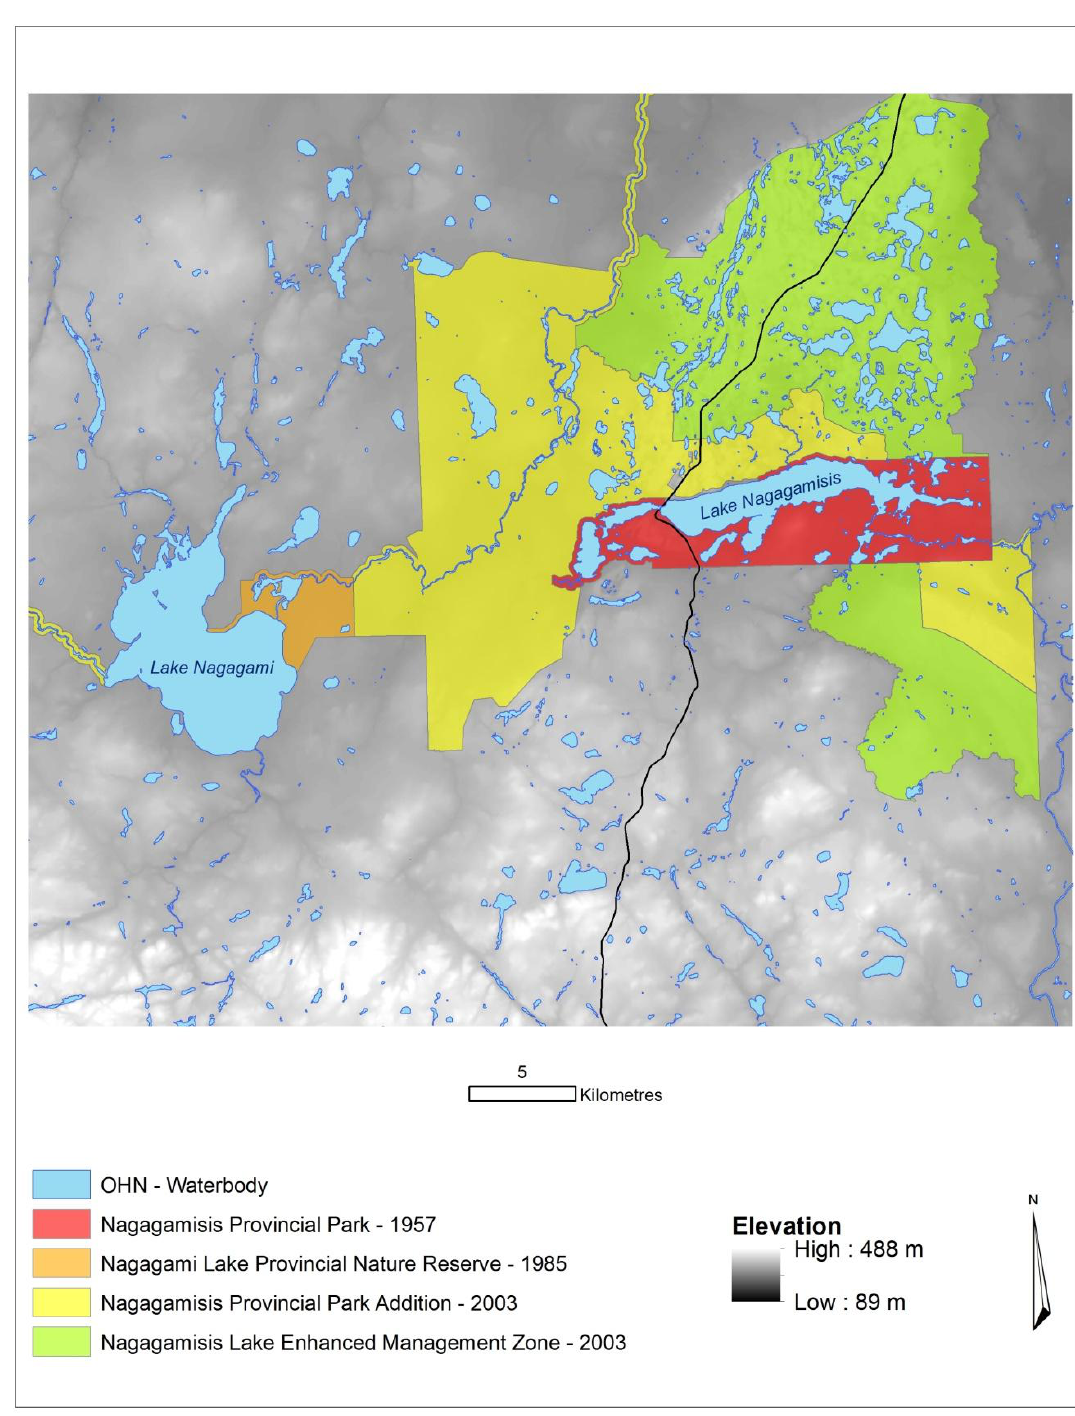
Figure 2. Nagagamisis central plateau signature